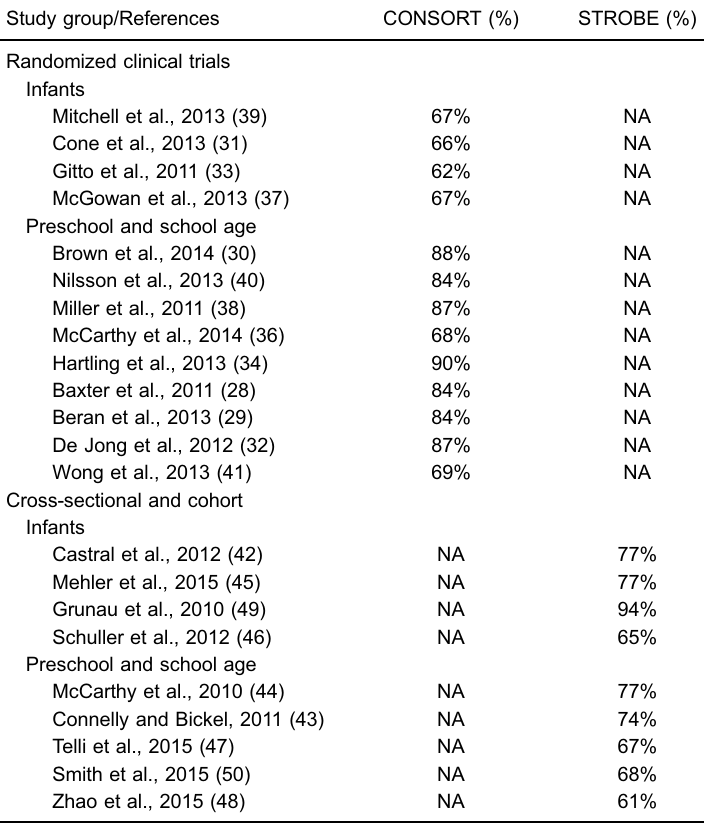
Table 1. Methodological quality of the studies based on the percentage of con- forming items of the CONSORT and STROBE guidelines